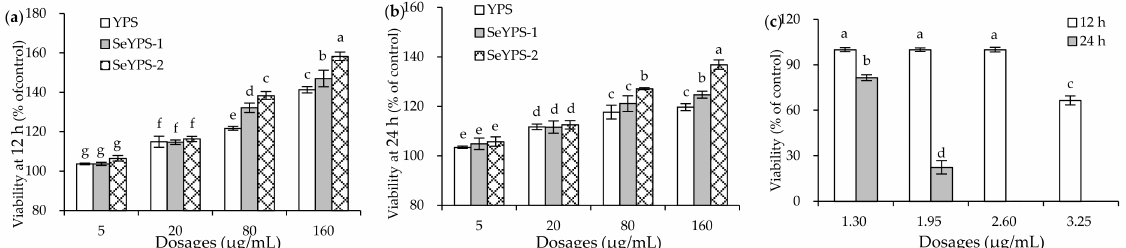
Figure 1. The viability values of the macrophages exposed to YPS, SeYPS-1, SeYPS-2 ( a , b ) or Na 2 SeO 3 ( c ) for 12 or 24 h. Different letters above the columns indicate that the one-way ANOVA of the mean values differs significantly ( p <